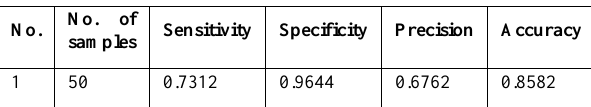
Table 2. Performance of the proposed classification system.